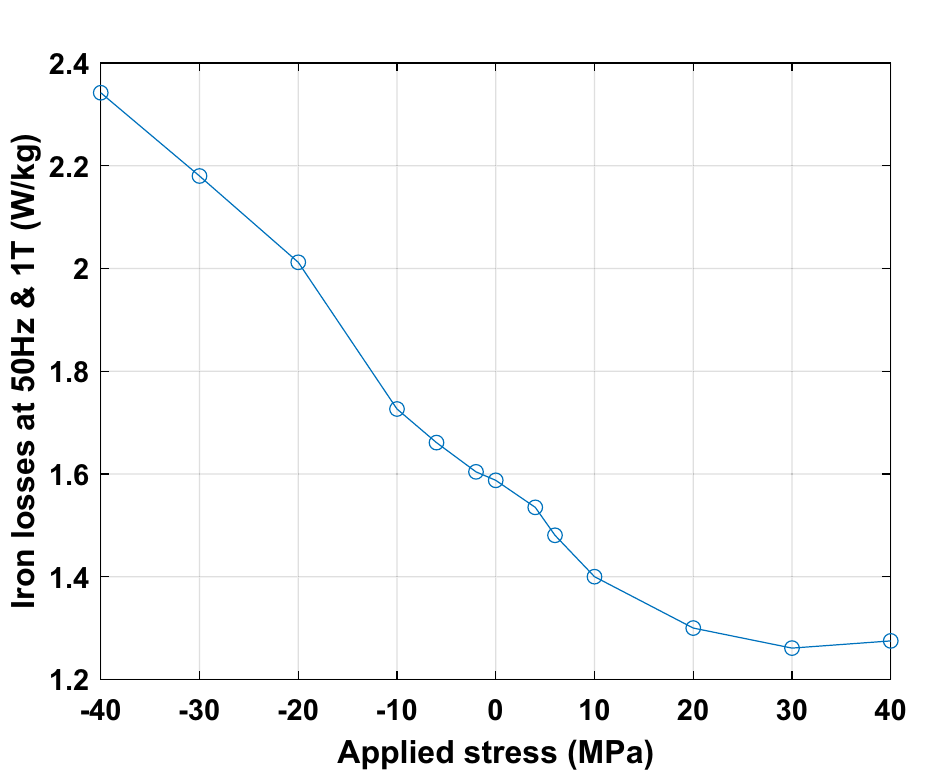
Figure 27. Evolution of the iron losses at 1 T as a function of applied mechanical